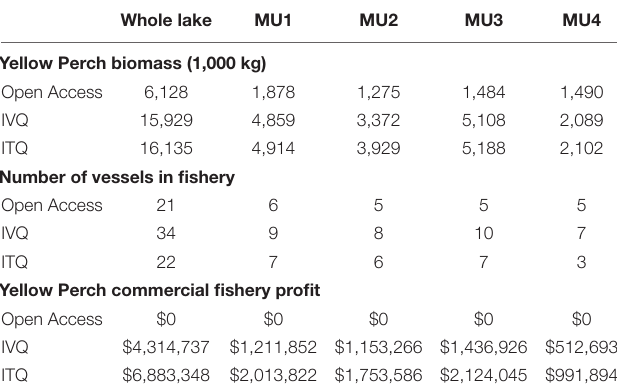
TABLE 3 | Whole lake and management unit (MU) values for steady state stock size (biomass), size of fishing fleet, and fishery profits for fisheries models. Whole lake